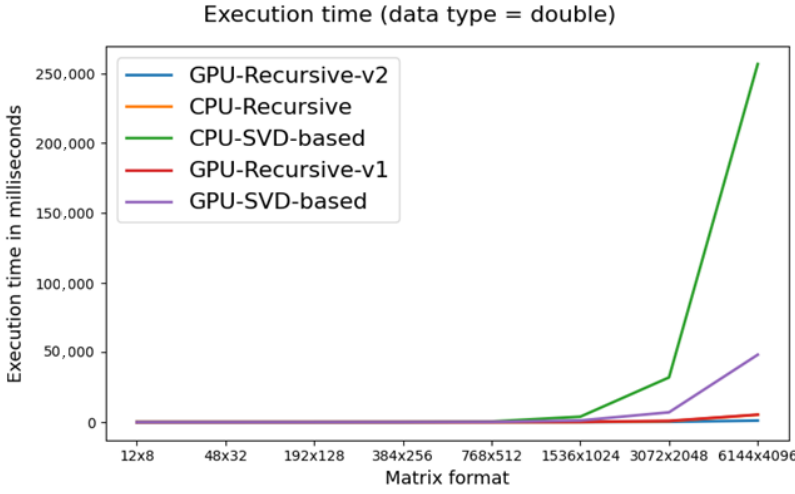
3.10, PyTorch 1.12.1 (with CUDA 10.2), and OpenCV 4.6. Figure 7. Time in milliseconds to calculate the pseudoinverse of float matrix. Figure 7. Time in milliseconds to calculate the pseudoinverse of float matrix.